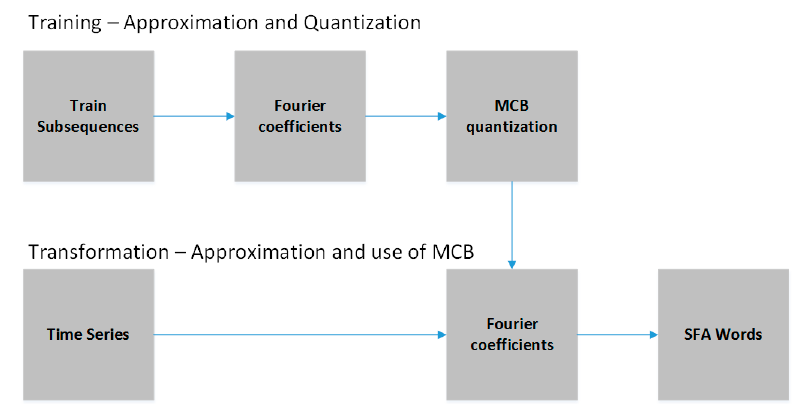
Figure 9. Flow of SFA steps.